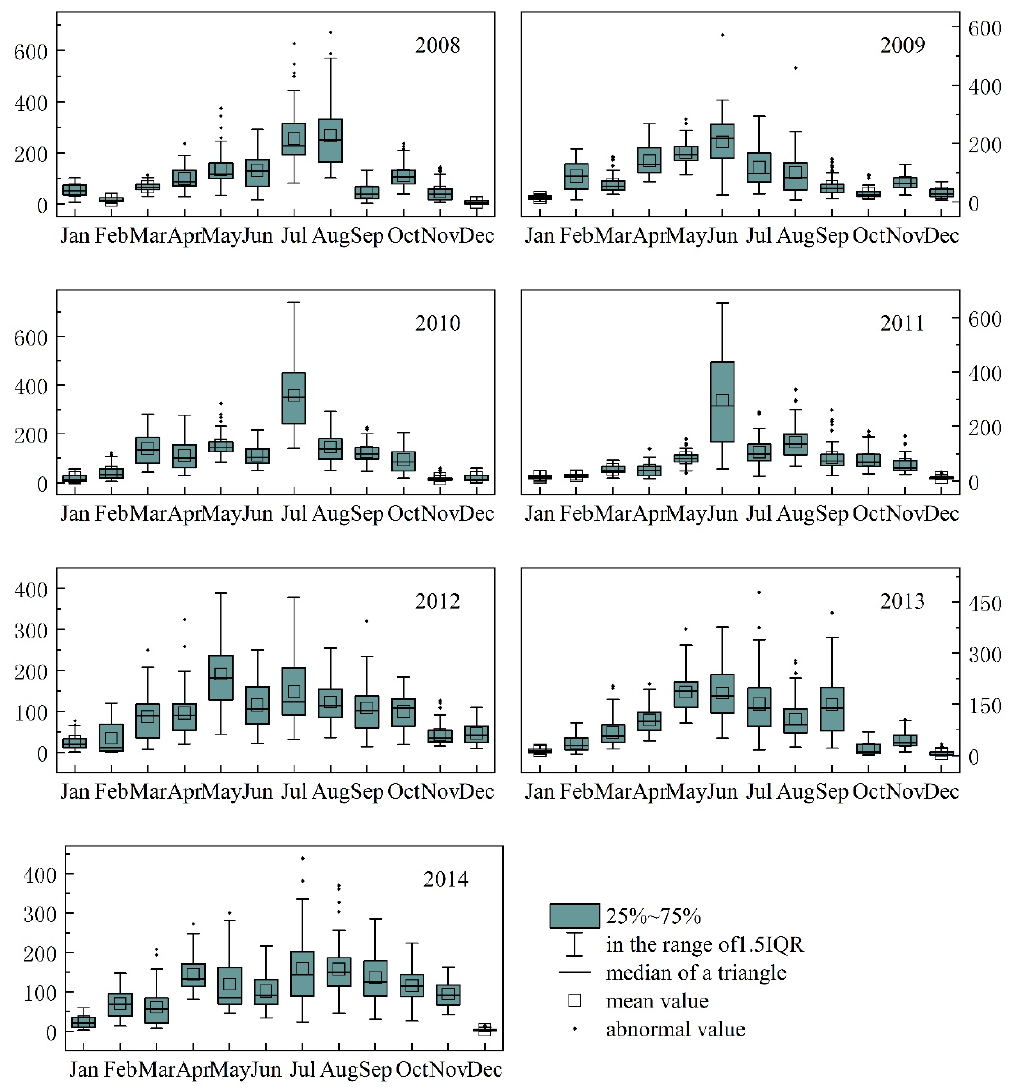
Figure 3. The monthly precipitation distribution from 2006 to 2014.